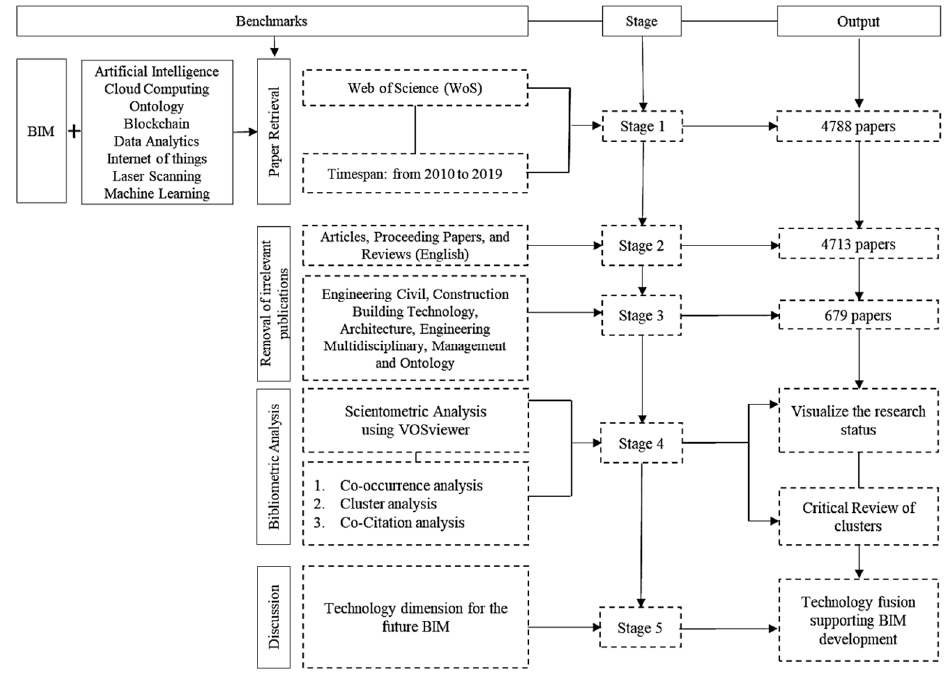
Figure 1. Research Figure 1. Research methodology.